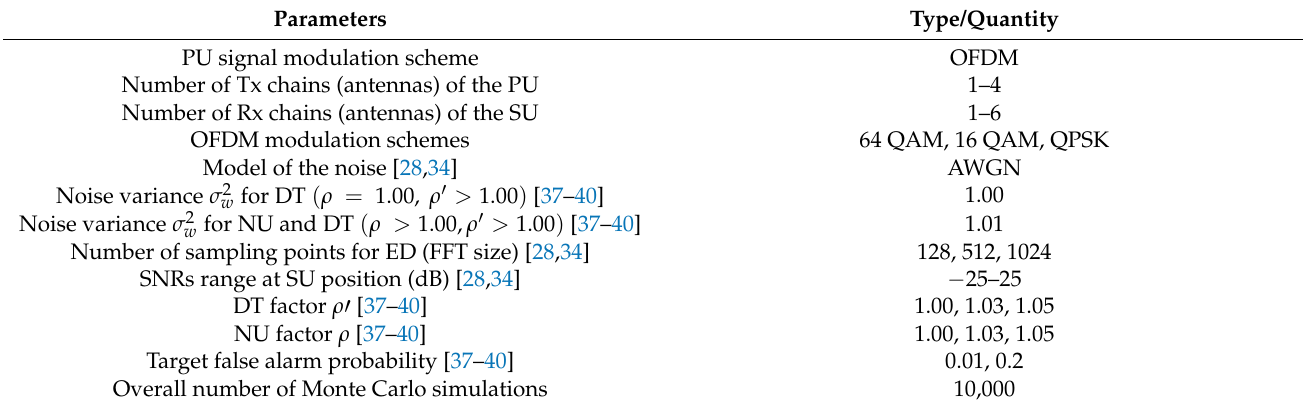
Table 3. Parameters used in the process of